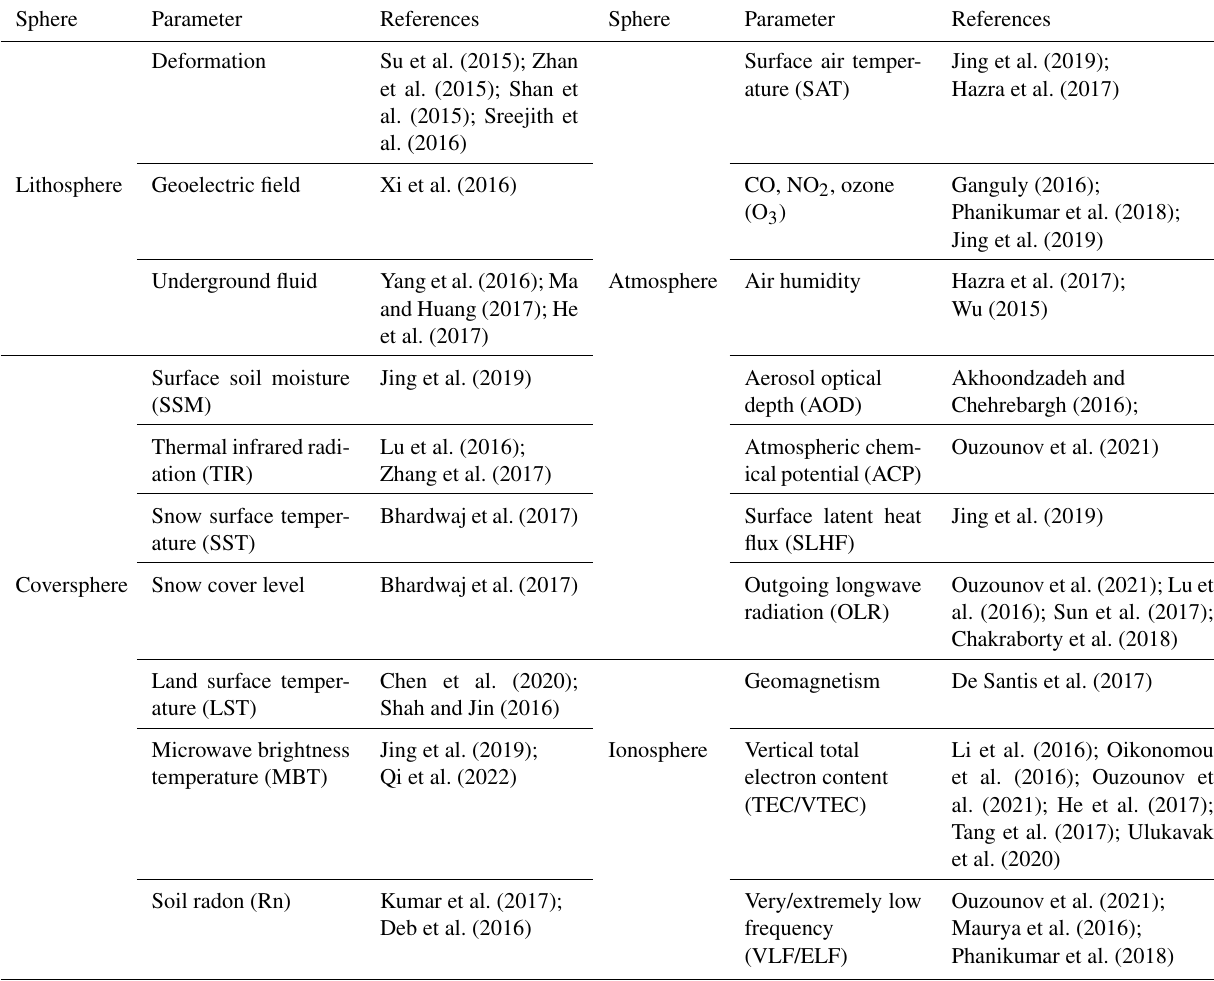
Table 1. Anomalous parameters in multiple geospheres reported on the 2015 Nepal earthquake sequence.